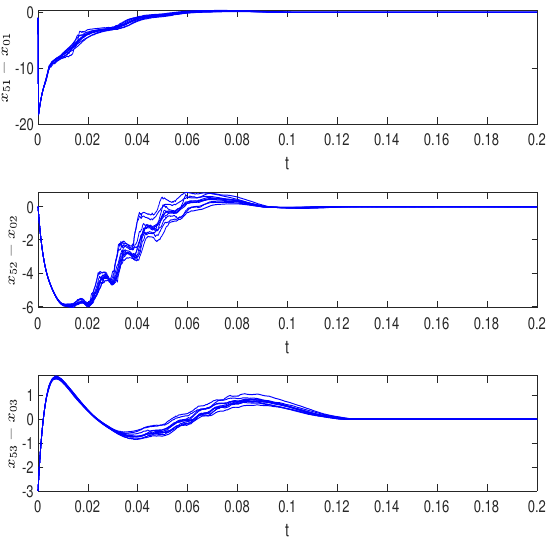
Figure 6. Ten paths of the tracking error between the 5th subchain and the leader with protocol Fig.6. 10 paths of the tracking error between the 5-th subchain and the leader with protocol (4.2).